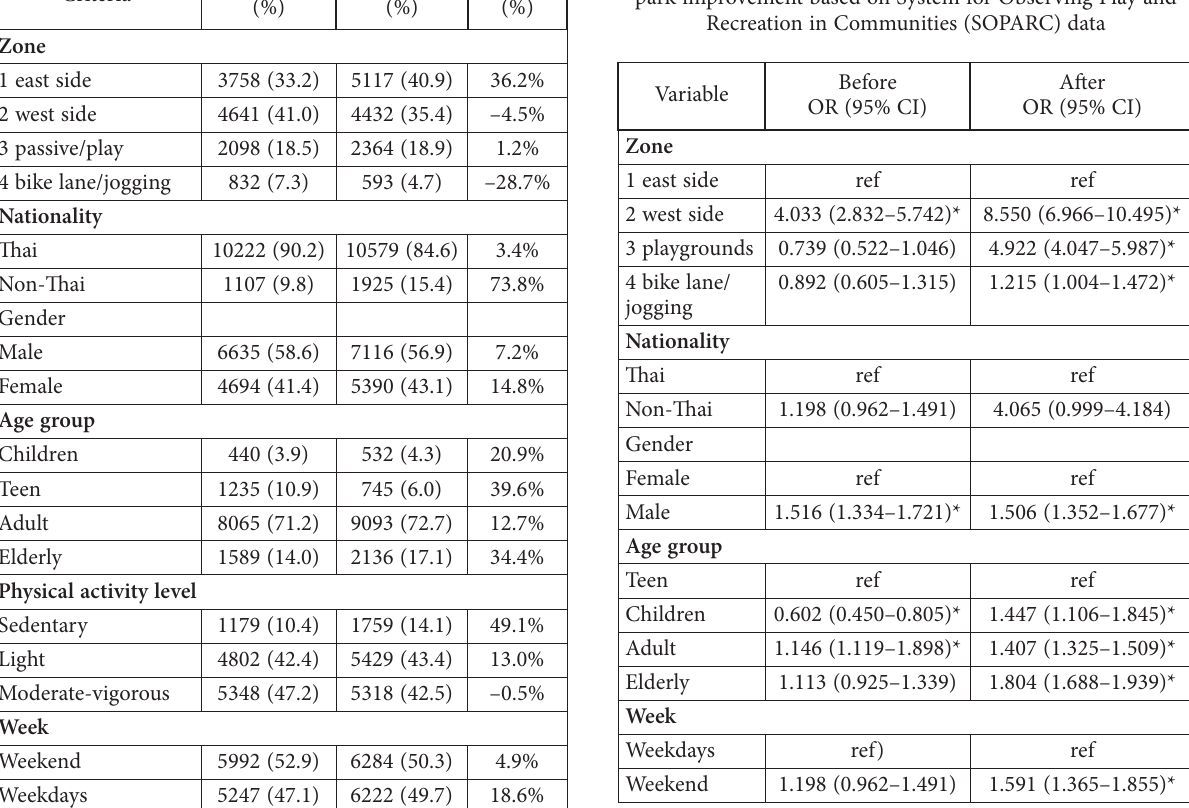
Table 3. Comparison of active park use before and